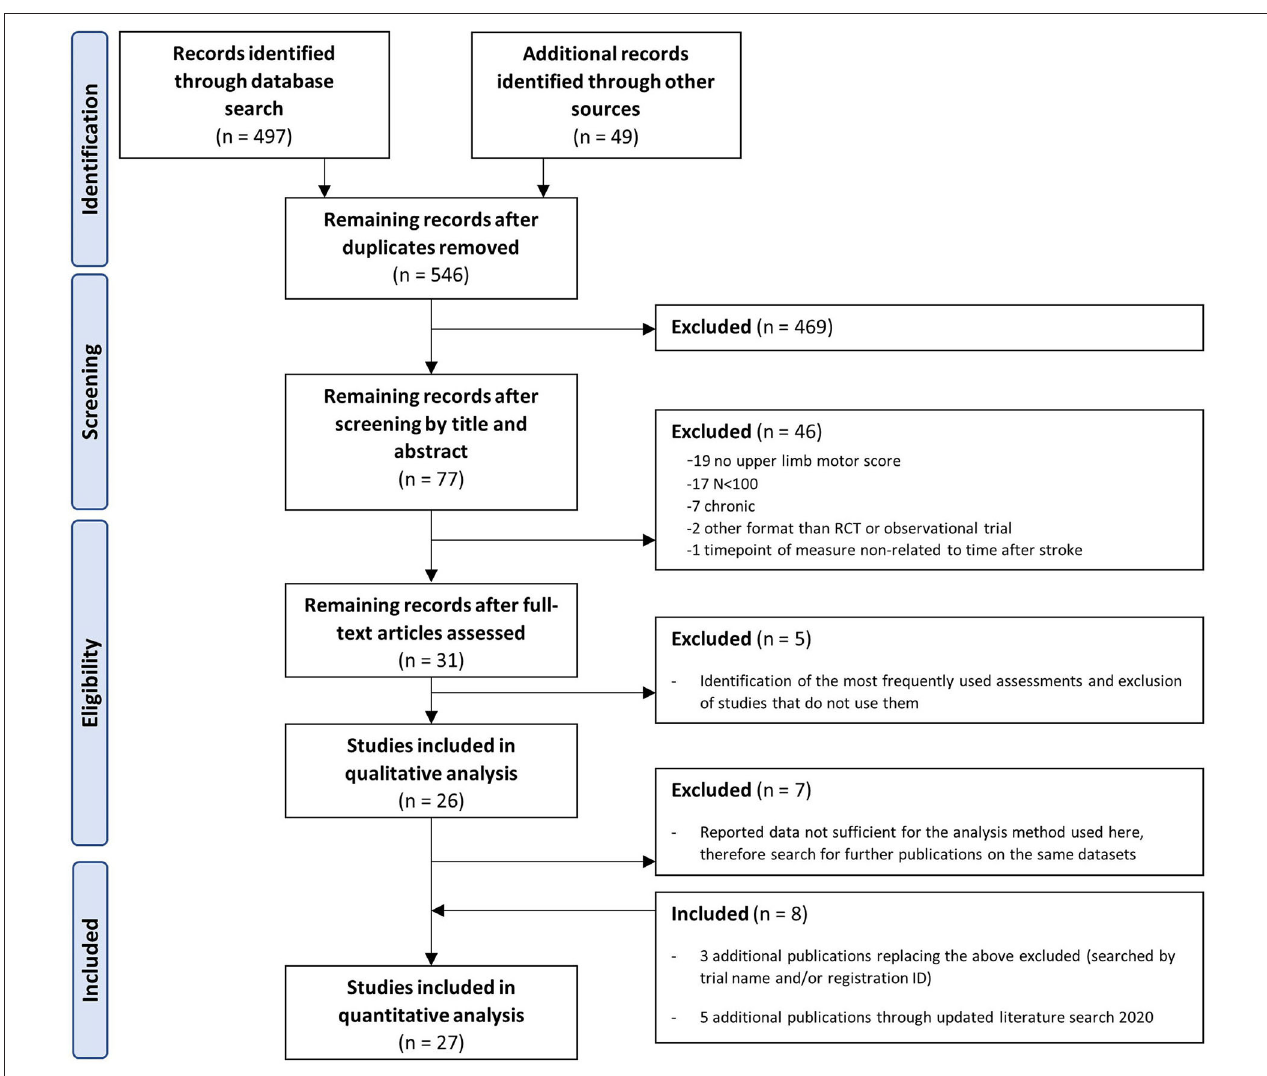
FIGURE 1 | Prisma flow diagram displaying the literature search and eligibility checking